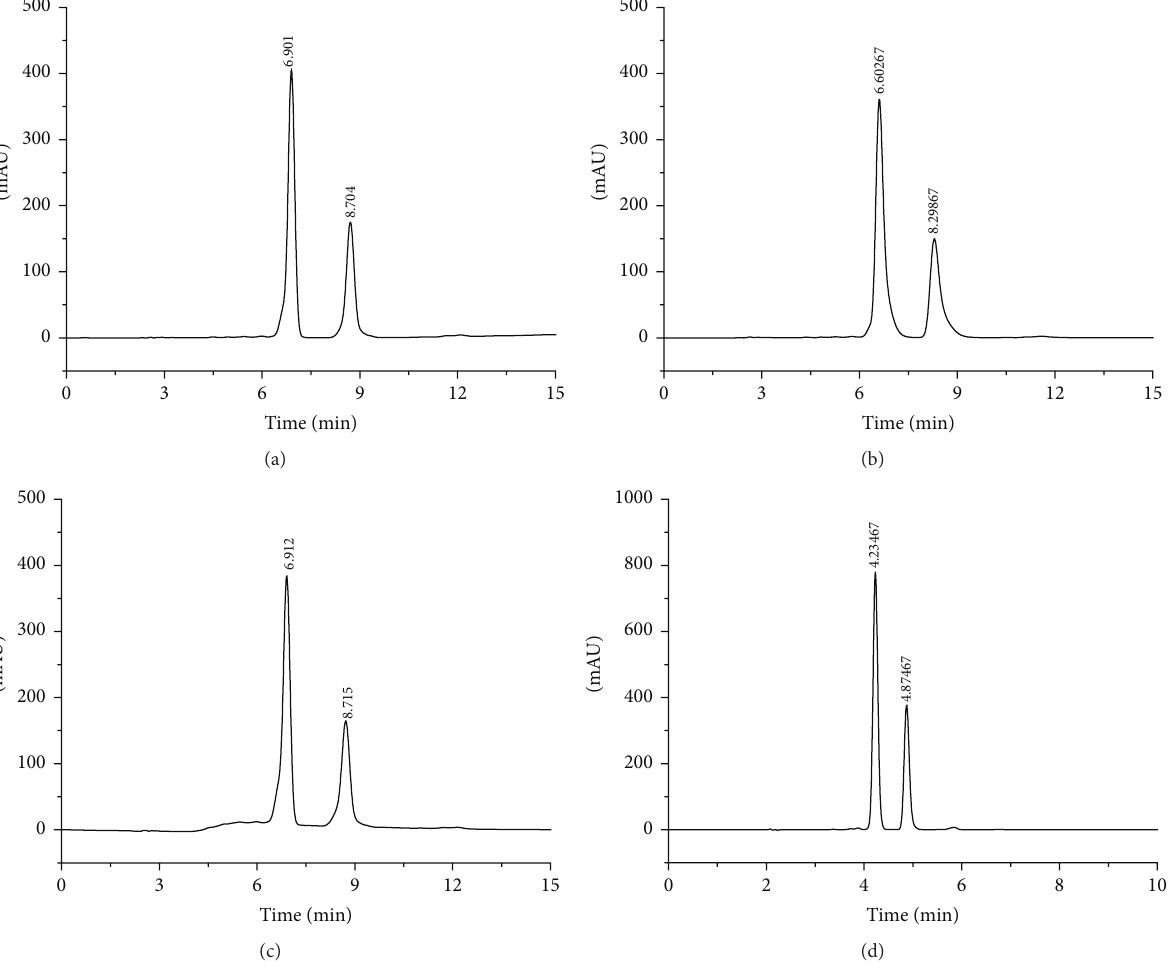
Figure6:HPLCchromatogramofcapsaicinindifferentmobilephasecondition.(a)Methanol : water=70 :30,(b)methanol :water :H 3 PO 4 = 70 :30 : 0.1, (c) methanol : water :triethylamine = 70 : 30: 0.05, and (d) acetonitrile :water = 70 :30.